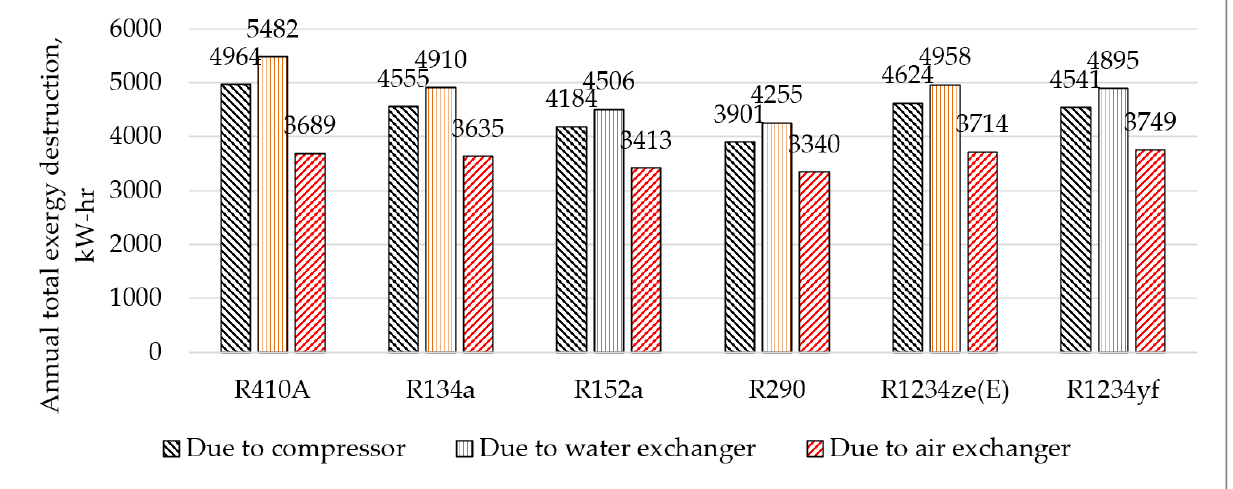
Figure 8. Values of the total exergy destruction E yr D , k (kWh) in the investigated heat pump with different working fluids after thermodynamic improvement of its components.